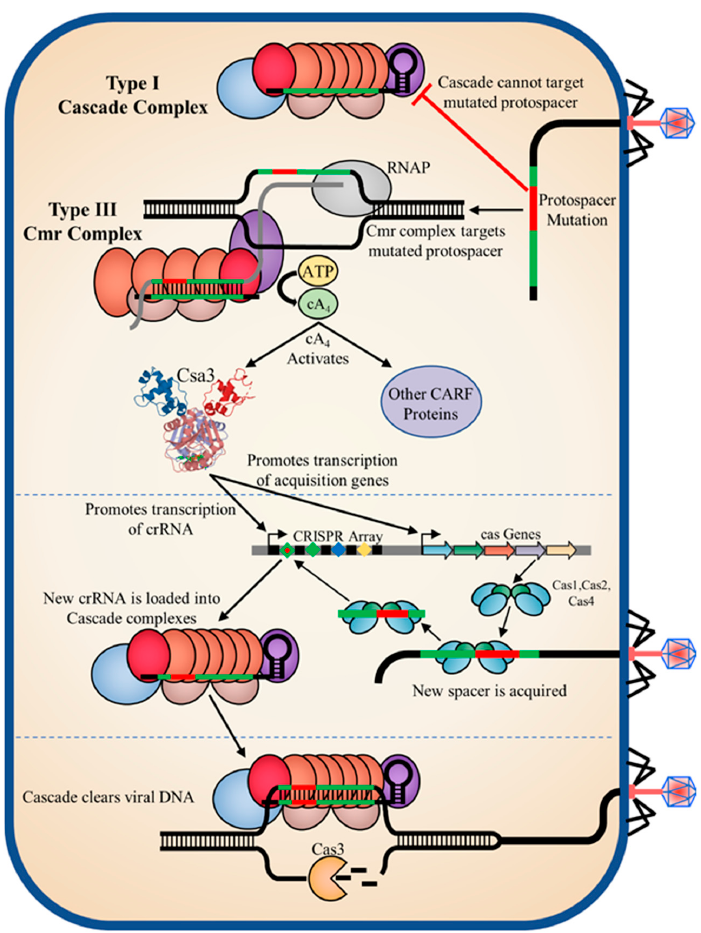
Figure 10. Model for an integrated Class 1 immune response. (Top) Infection with a virus harboring an inexact match to archived CRISPR spacers may hinder recognition by PAM-dependent type I systems, allowing the infection to progress to transcription of viral mRNA. The more promiscuous PAM-independent type III interference complexes may still recognize the mRNA target and produce cA 4 . cA 4 activates Csa3a (and potentially Csa3b), which promotes transcription of acquisition genes, resulting in spacer acquisition. Csa3a also promotes transcription of new crRNAs which are loaded into aCascade surveillance complexes, restoring recognition of the invading viral DNA to the type I